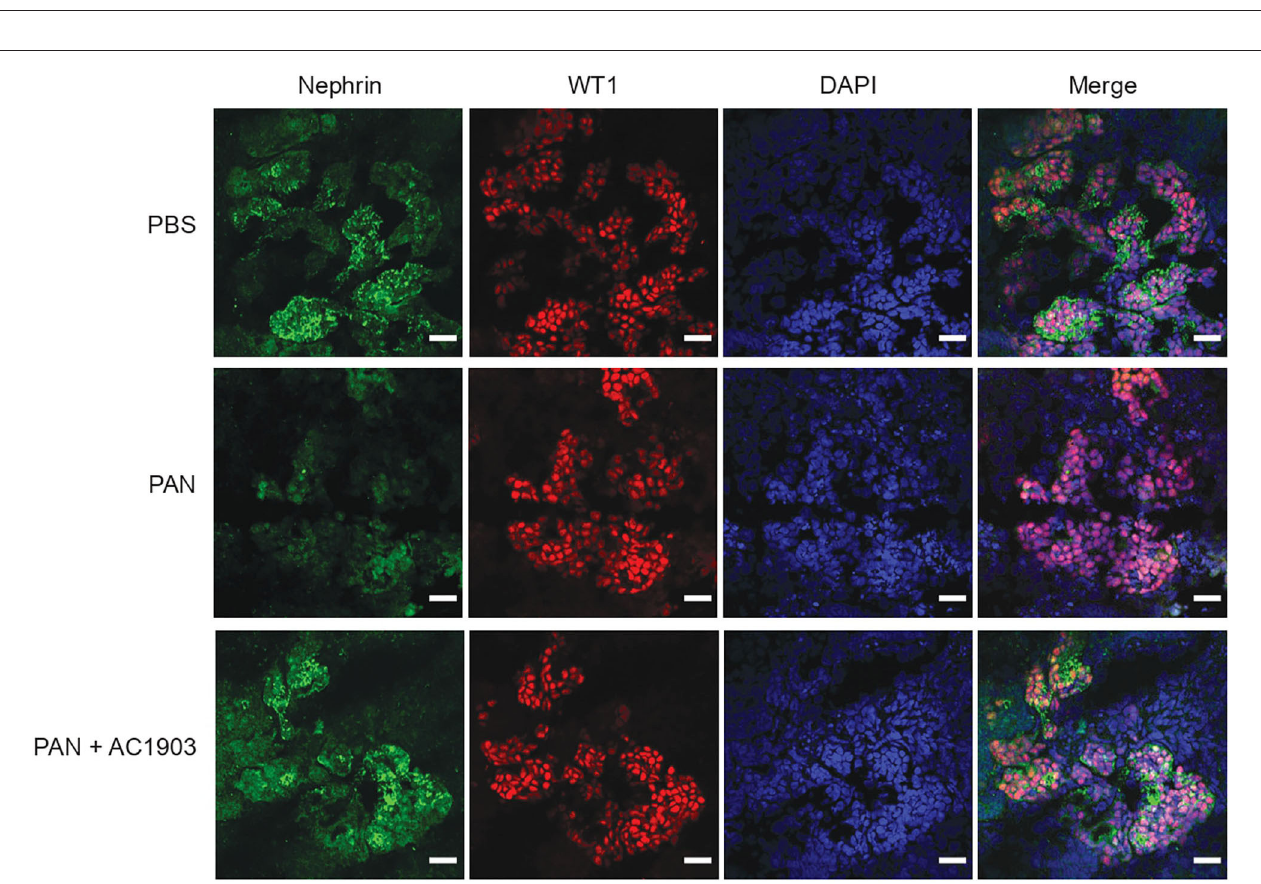
FIGURE 3 | diary plots of whole-cell currents from iPodos in response to TRPC5 channel agonist Englerin A (100nM) in the absence or presence of TRPC5 channel inhibitor AC1903 (30 µ M). Currents shown are from + 100mV and − 100mV of a ramp protocol. (C) Representative TRPC5 channel current-voltage (I-V) curves from iPodo whole-cell recording. (D) Statistical analysis of I-V curves from iPodos treated with Englerin A in the absence or presence of AC1903. * p < 0.05, *** p < 0.001. (E) Representative cytosolic ROS images in iPodos after 24-h treatment with PAN (150 µ g/mL) with or without AC1903 (30 µ M). Scale bar 10 µ m. (F) Statistical analysis of the ROS signal intensities. *** p < 0.001.